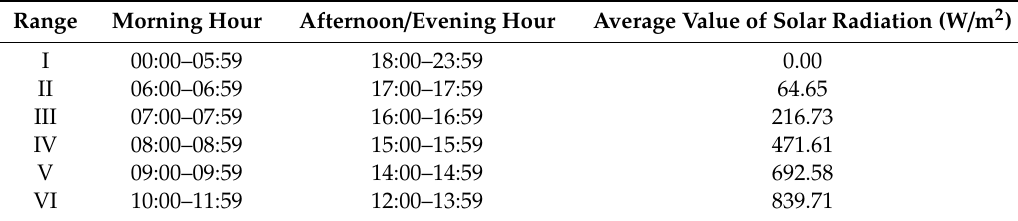
Table 2. Hourly range with similar solar radiation [28].